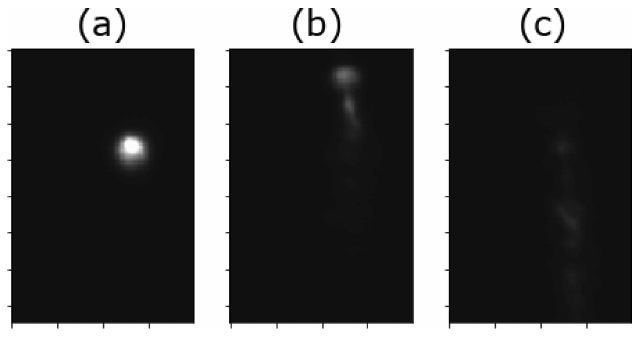
Figure 2 Three examples of positions in the search space with the corresponding conditions for alignment and noise issues. Image ( a ) shows the spot from a well aligned CRL, producing a tight and bright spot, while ( b ) shows a diffuse tail demonstrating its misalignment, and ( c ) shows only a diffuse streak from worse alignment